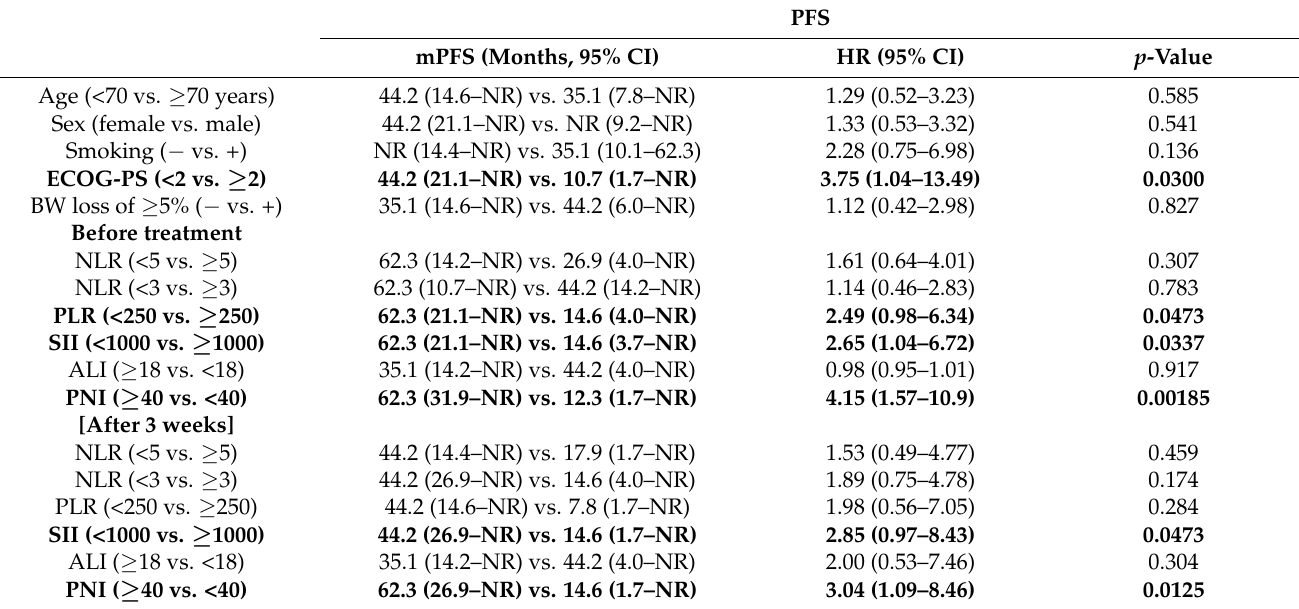
Table 2. Univariate analyses of predictors for progression-free survival